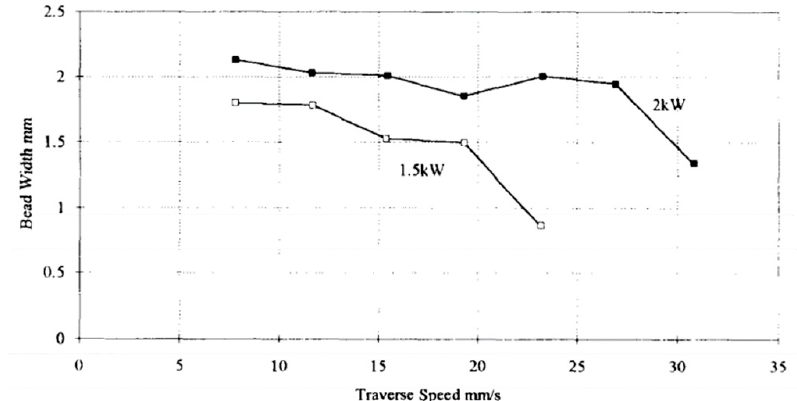
Figure 22. Variation of track width with respect to the travel speed varying the laser power (repro- duced with permission from [101]; Copyright © 1995 Elsevier).